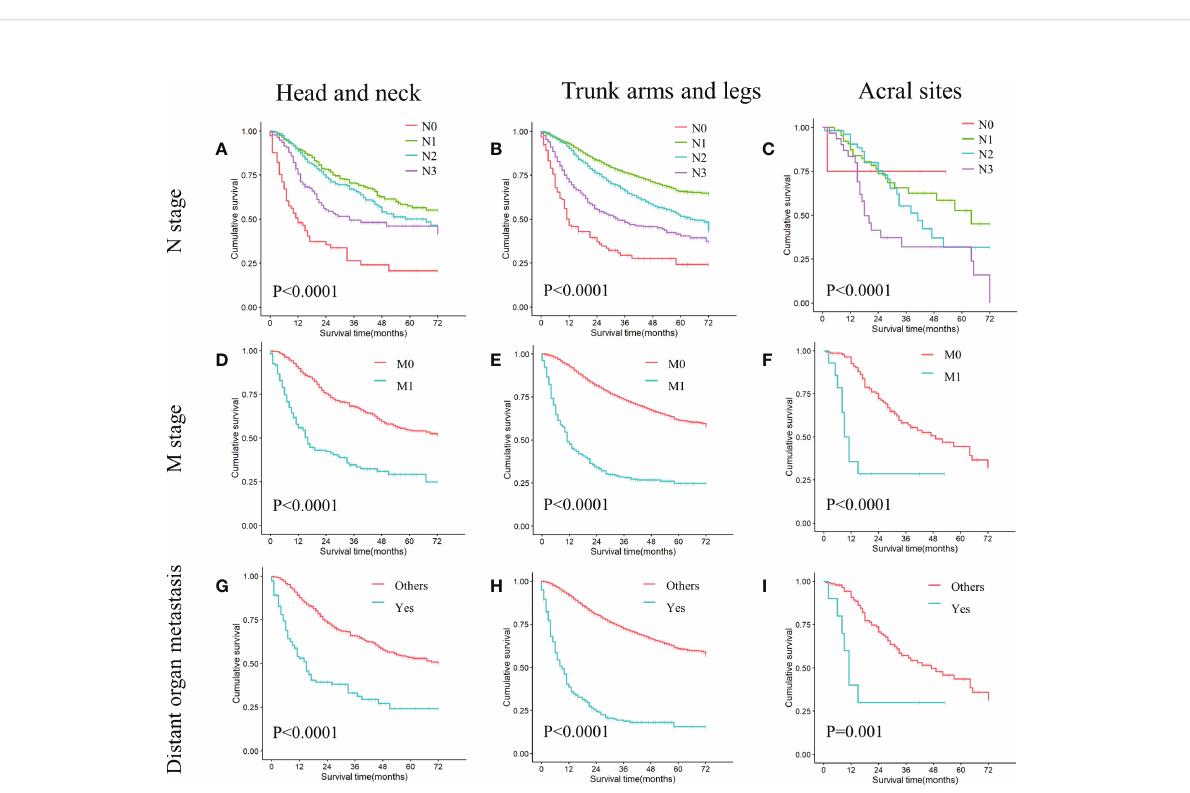
FIGURE 3 KM curves of strati fi ed analysis in the ICIs era: N stage, M stage, distant organ metastasis. (A) Comparing survival differences in N stage in head and neck melanoma (P<0.0001). (B) Comparing survival differences in N stage in trunk arms and legs melanoma (P<0.0001). (C) Comparing survival differences in N stage in acral melanoma (P<0.0001). (D) Comparing survival differences in M stage in head and neck melanoma (P<0.0001). (E) Comparing survival differences in M stage in trunk arms and legs melanoma (P<0.0001). (F) Comparing survival differences in M stage in acral melanoma (P<0.0001). (G) Comparing survival differences in distant organ metastasis in head and neck melanoma (P<0.0001). (H) Comparing survival differences in distant organ metastasis in trunk arms and legs melanoma (P<0.0001). (I) Comparing survival differences in distant organ metastasis in acral melanoma